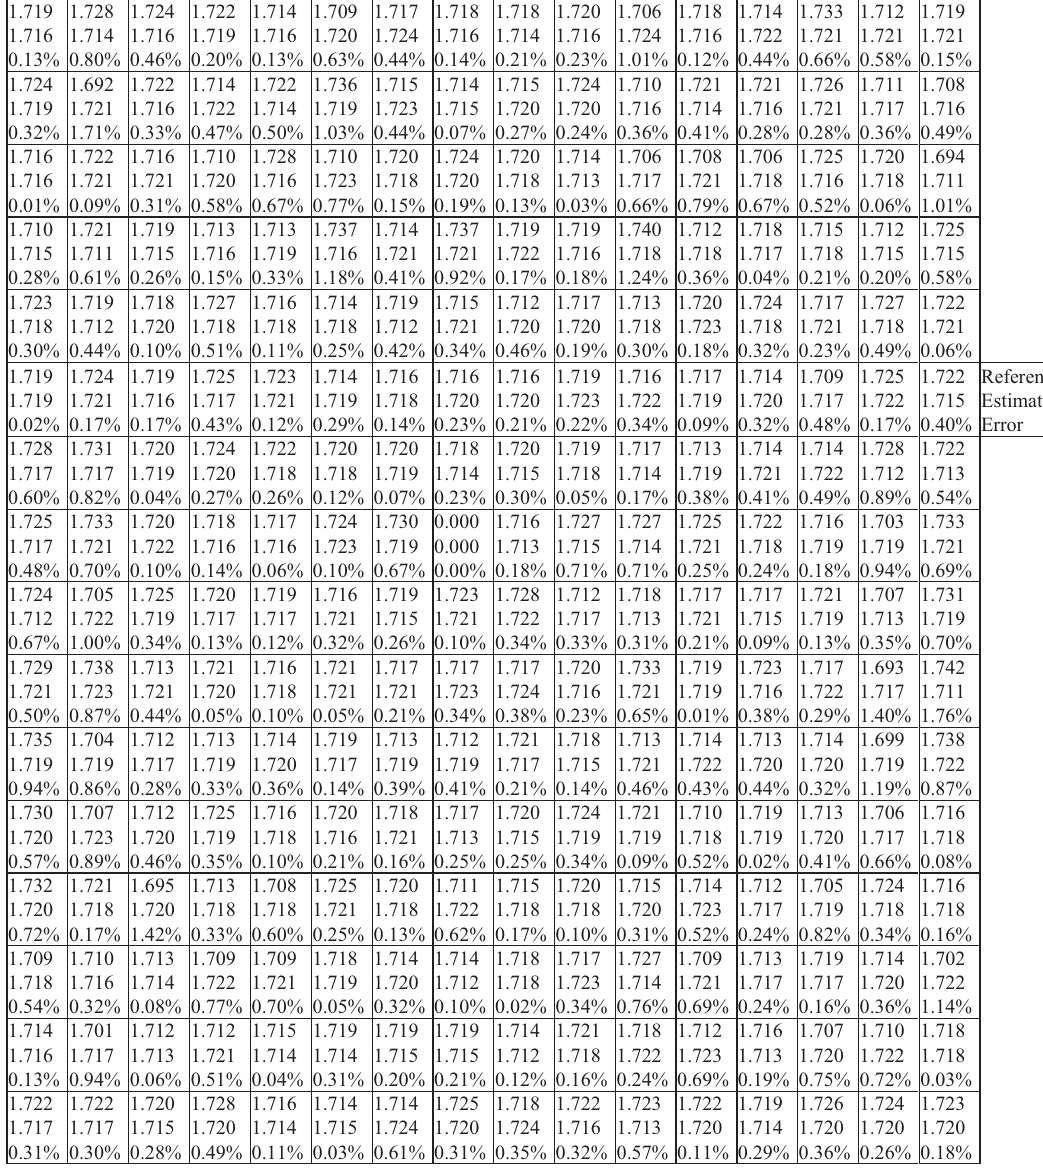
Fig. 7. Ratios between maximum and average values of the pin to pin fl uxes for assembly